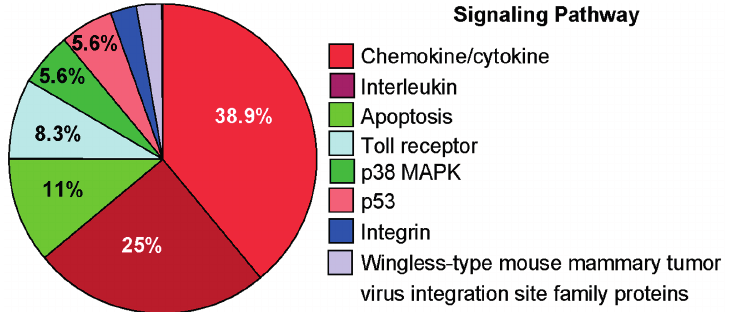
Figure 5. Signaling pathways induced by exposing the lungs to 8-oxoG base. Analysis by PANTHER software included genes that were upregulated in Cluster A and B (Figure 4). The percentages of genes for each category were calculated as described previously